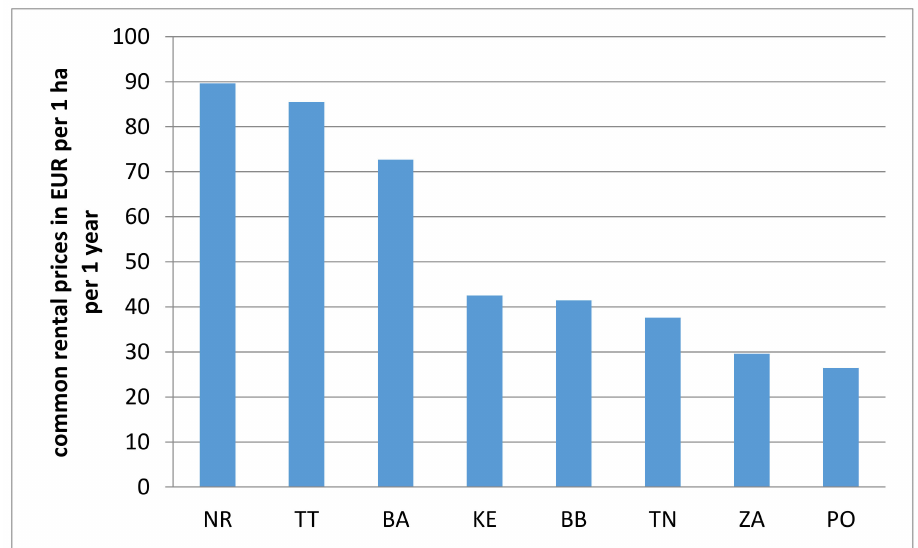
Figure 5. Common average rental prices stipulated by the particular district o ffi ces in the regions of Slovakia in 2018. Source: own calculation on the basis of data from Slovak Land Fund, 2018. (Explanation of remarks: the Bratislava region (BA), the Trnava region (TT), the Trenˇc í n region (TN), the Nitra region (NR), the Žilina region (ZA), the Bansk á Bystrica region (BB), the Prešov region (PO) and the Košice region